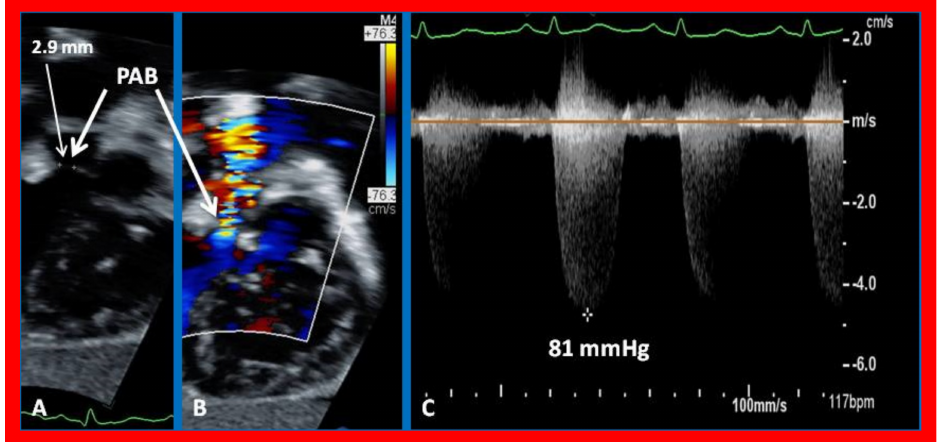
Figure 10. Selected echo-Doppler images illustrating the pulmonary artery band (PAB). Note, narrow PAB diameter by two-dimensional echo in ( A ) and by color Doppler imaging in ( B ). Continuous wave Doppler reveals a significant gradient (81 mmHg) across the PAB ( C ). Reproduced from Reference